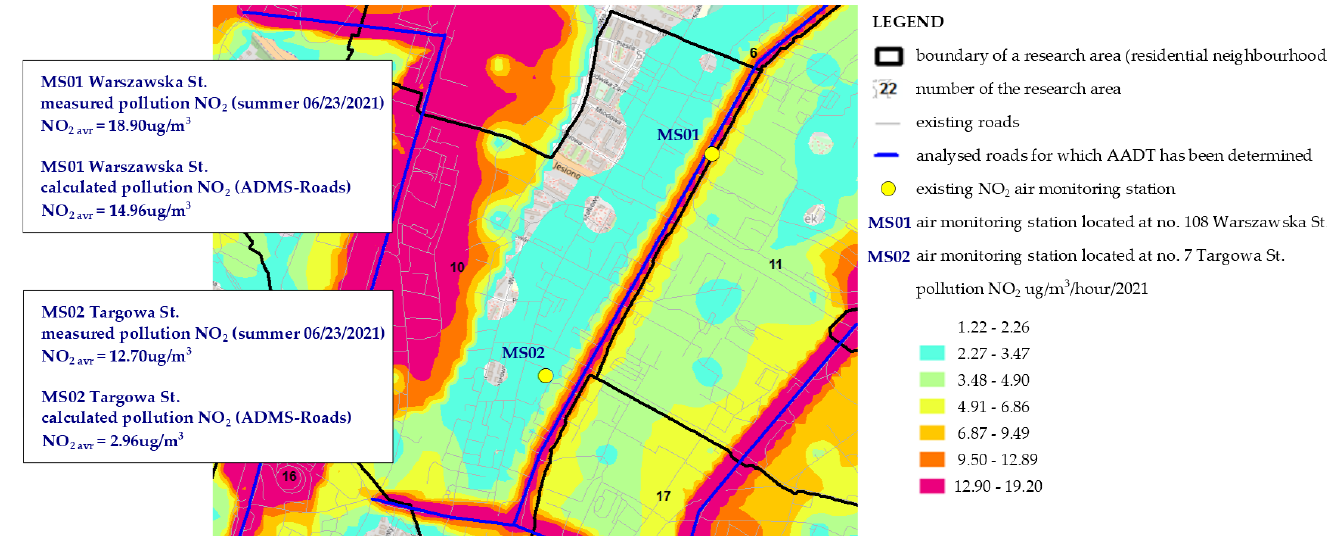
Figure 13. NO 2 level measured at two air monitoring stations against the calculated level of NO 2 generated from road transport.